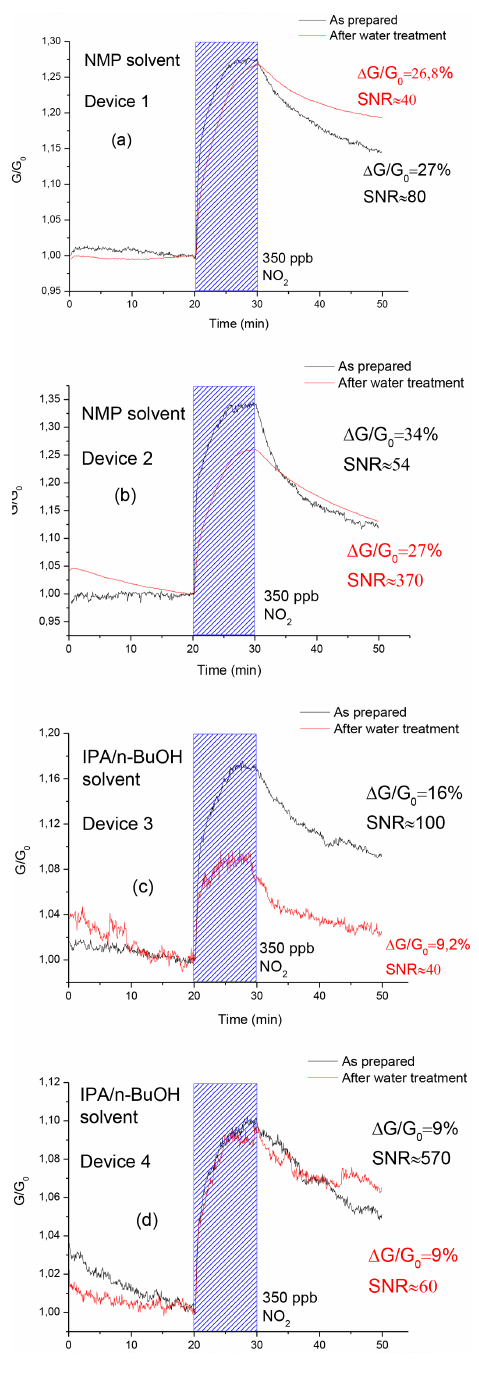
Figure 3. Normalized electrical conductance behaviors for another four chemi-resistors that have been realized as described in Fig. 1 (devices 1 and 2) and in Fig. 2 (devices 3 and 4). The black and red lines in each panel report the detected device signal as soon as pre- pared and after the restoration by the dipping method, respectively. The protocol employed in the tests is the standard one adopted for the previous